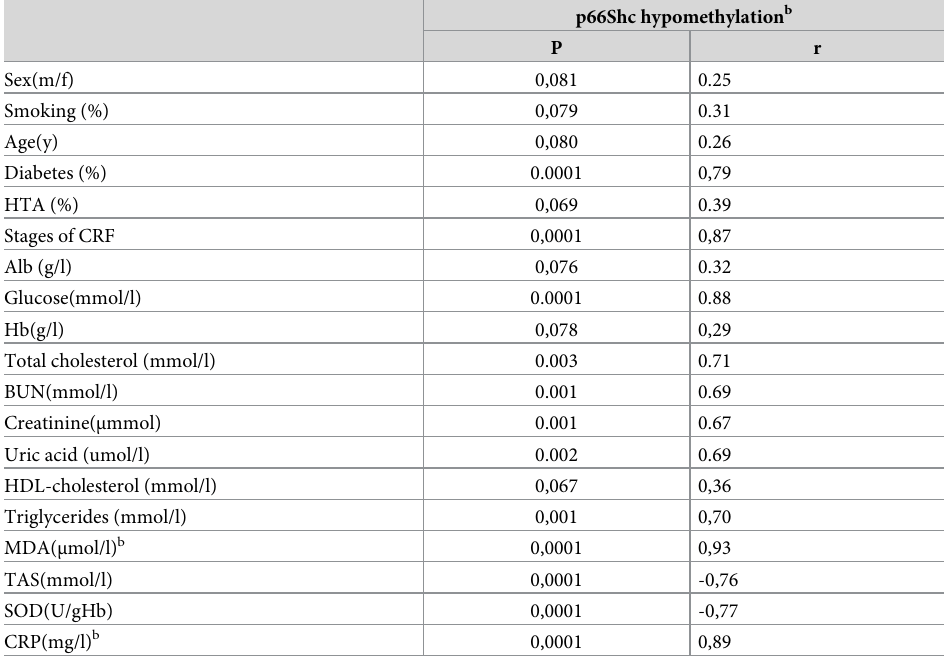
Table 4. Correlation between p66Shc DNA hypomethylation and clinical characteristics, inflammation and oxida- tive stress biomarkers in CRF subjects by univariate